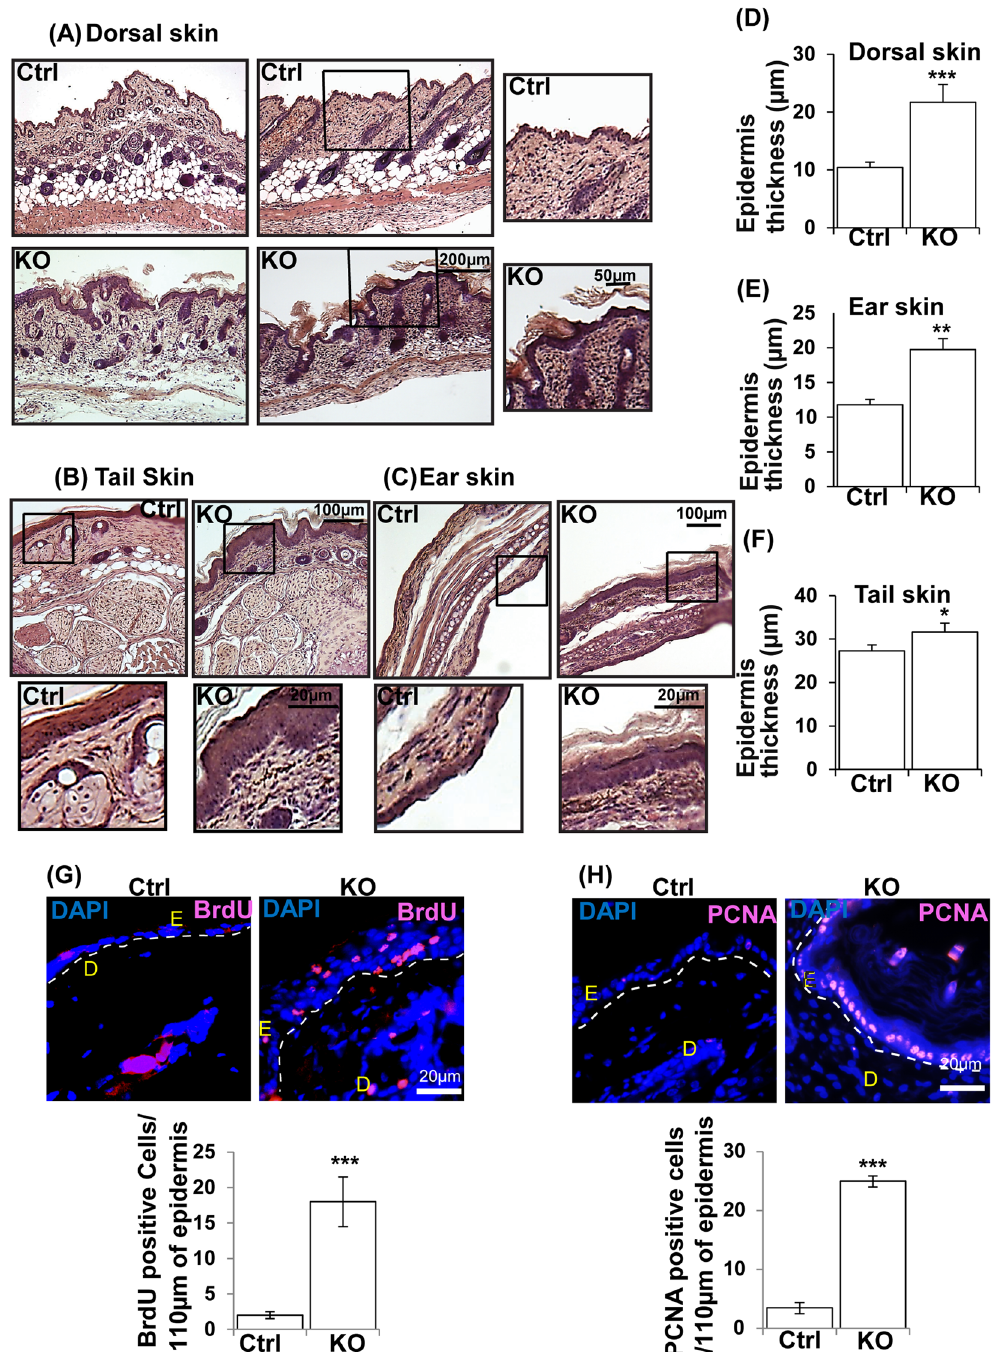
Figure 2. Loss of N-WASP expression in keratinocytes caused hyperproliferation of keratinocytes in N-WASP K14KO mice. (A) H & E stained dorsal skin, tail (B) and ear (C) sections of N-WASP K14KO and control mice on 23 rd day (n = 10). Quantification of epidermal thickening in skin (D) , ear (E) and tail (F) of control mice and N-WASP K14KO mouse skin sections (n = 5). (G) BrdU staining: Quantification of BrdU positive cells in epidermis of control (n = 3) and N-WASP K14KO (n = 4) mice skin at P23 (H) PCNA immunostaining of paraffin embedded dorsal skin sections of control and N-WASP K14KO mice at P23 and quantification of PCNA positive cells (n = 3). Results are mean ± SEM *** p < 0.001, ** p < 0.01, * p <